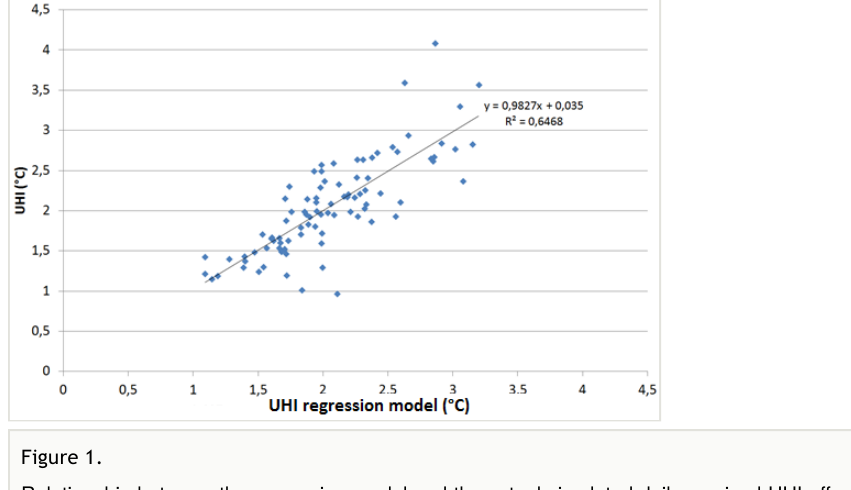
for the 100 European cities (De Ridder et al.